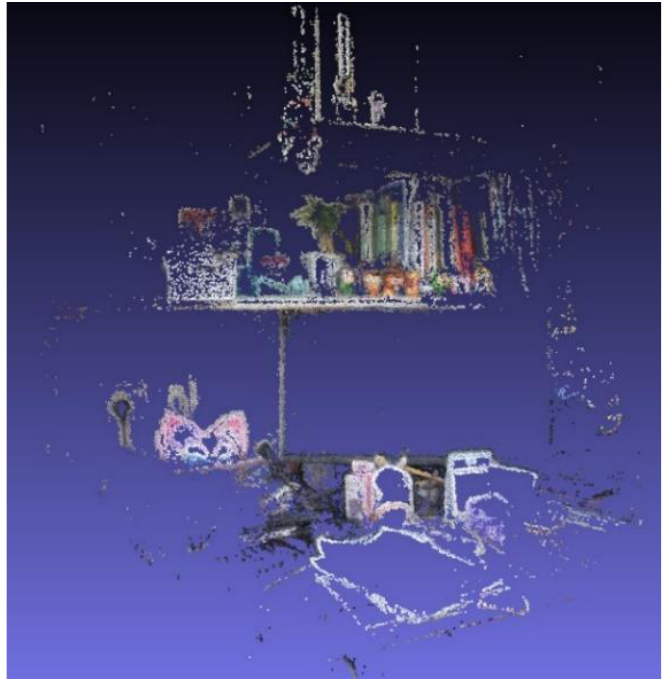
Figure 12. Three-dimensional reconstruction results of images shot by the compound-eye system.